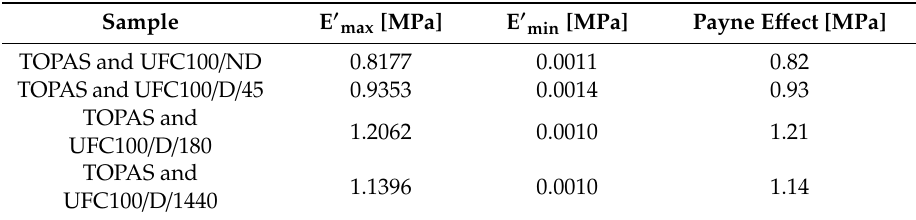
Table 6. Tabularized values of maximum and minimum storage modulus (E’) and the calculated Payne effect. Sample E’ max [MPa] Payne Effect [MPa]